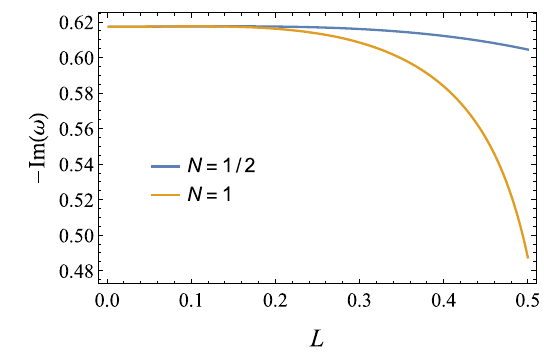
Fig. 15 QNMs with respect to L , where l = 3 and n = 0 are set. The left diagram represents the real parts of ω with respect to L for the cases of N = 1 / 2 and N = 1, respec-